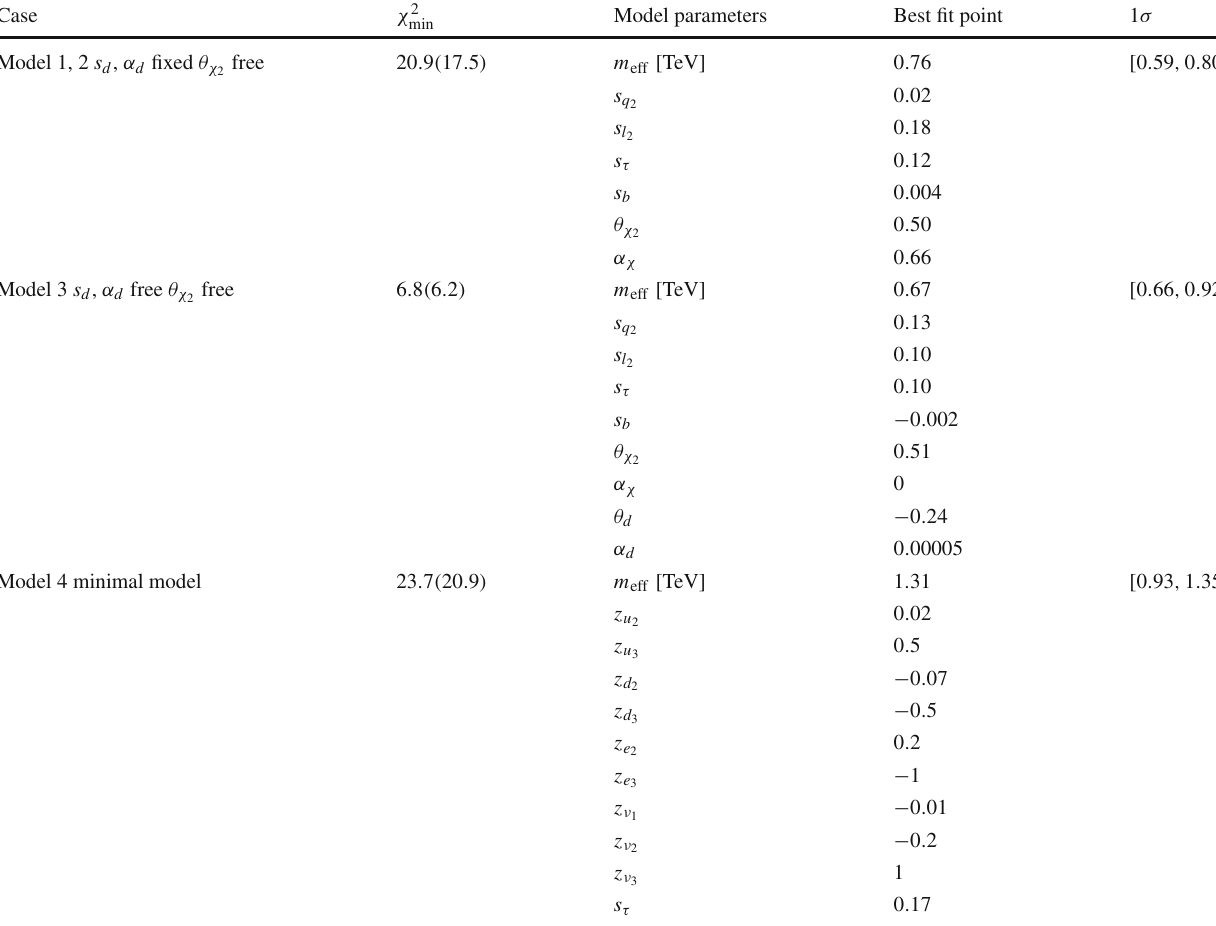
Table 3 Fit results for the different Models. In the χ 2 observables. For reference, in the SM χ 2 Case χ 2